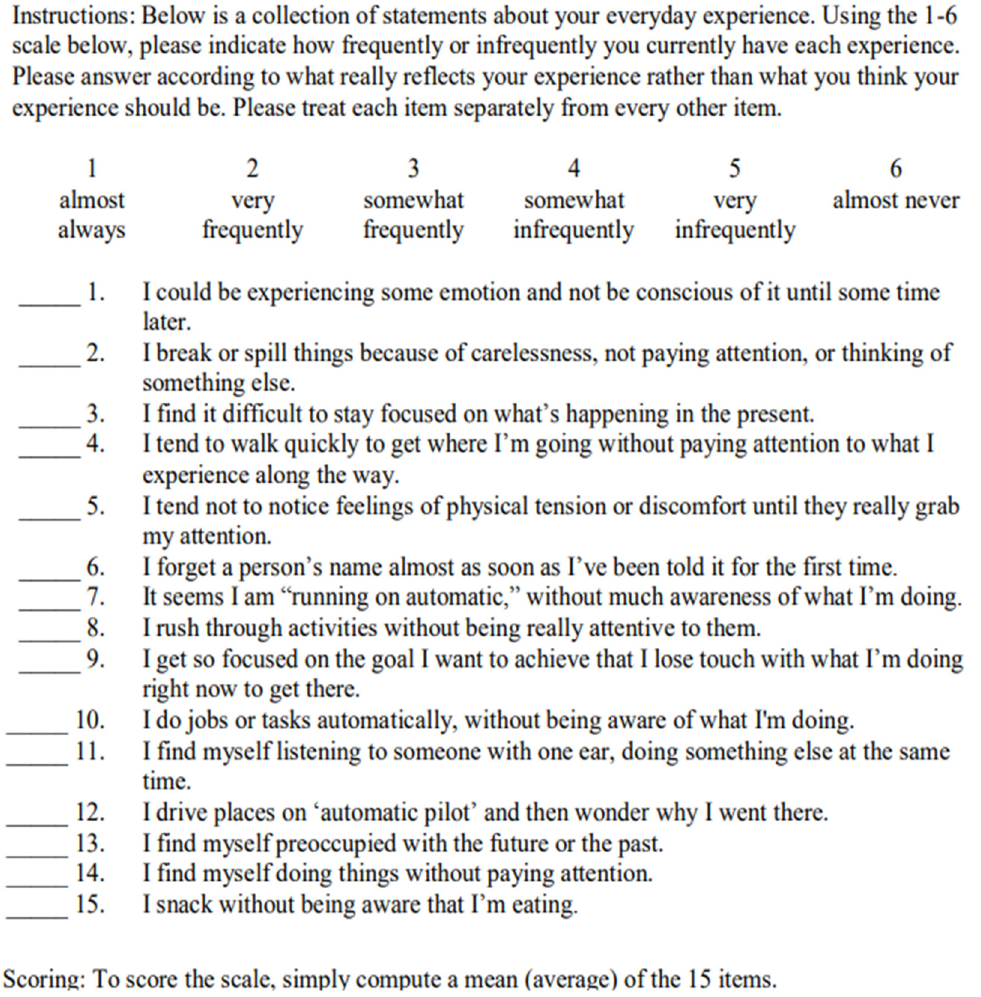
Figure A1. The original Mindful Attention Awareness Scale (MAAS).